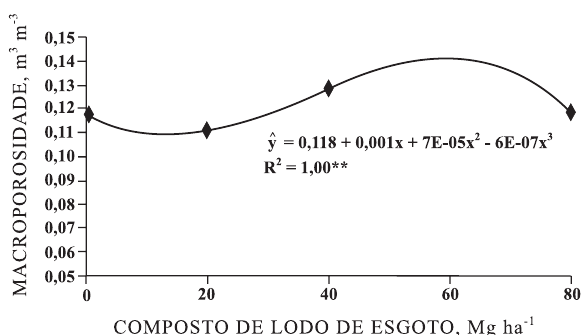
Figura 2. Análise de regressão para macroposidade do solo em função das doses crescentes de composto de lodo de esgoto, na camada de 0– 0,20 m (** = significativo a 1 %).